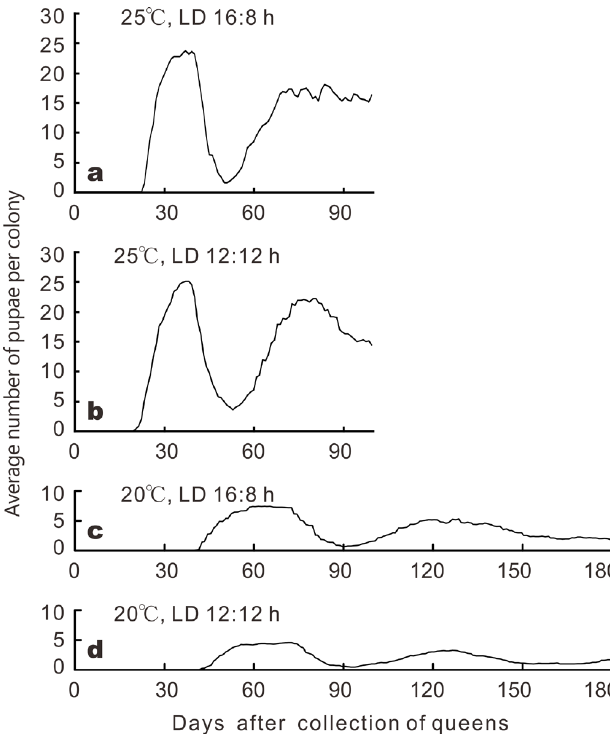
Fig 1 . Effects of photoperiod and temperature on the mean number of Lasius japonicus pupae. N =